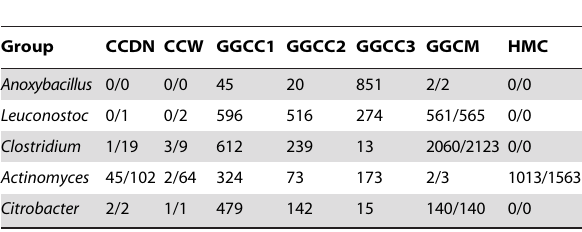
Table 1. The main cellulose-degrading bacteria present in the GGCC